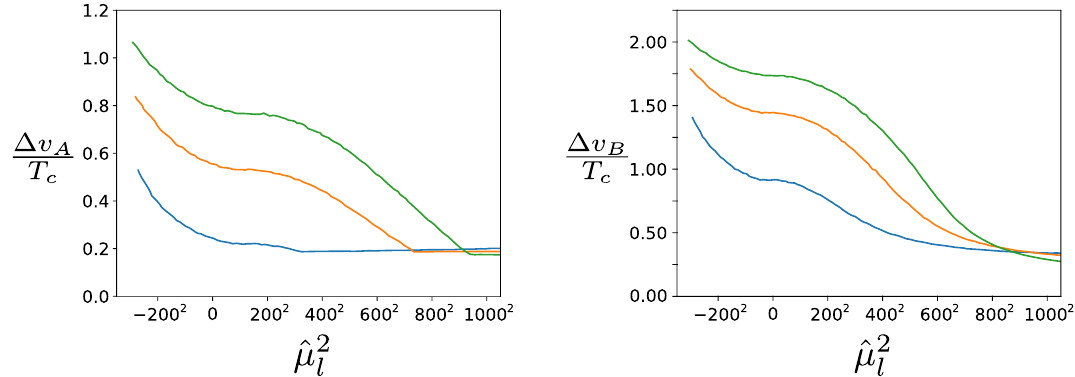
Figure 8. The phase transition strength ∆ v I ( T c ) /T c vs twin slepton soft mass squared ˆ µ 2 among all the three generations of the right- and left-handed twin sleptons) for tan β = 2 and µ sl = 90 GeV. Blue, orange and green lines correspond to ˜ y l set to 2 , 2 . 5 , and 3 , respectively. Each line ends at the point where one of the physical twin slepton masses was found